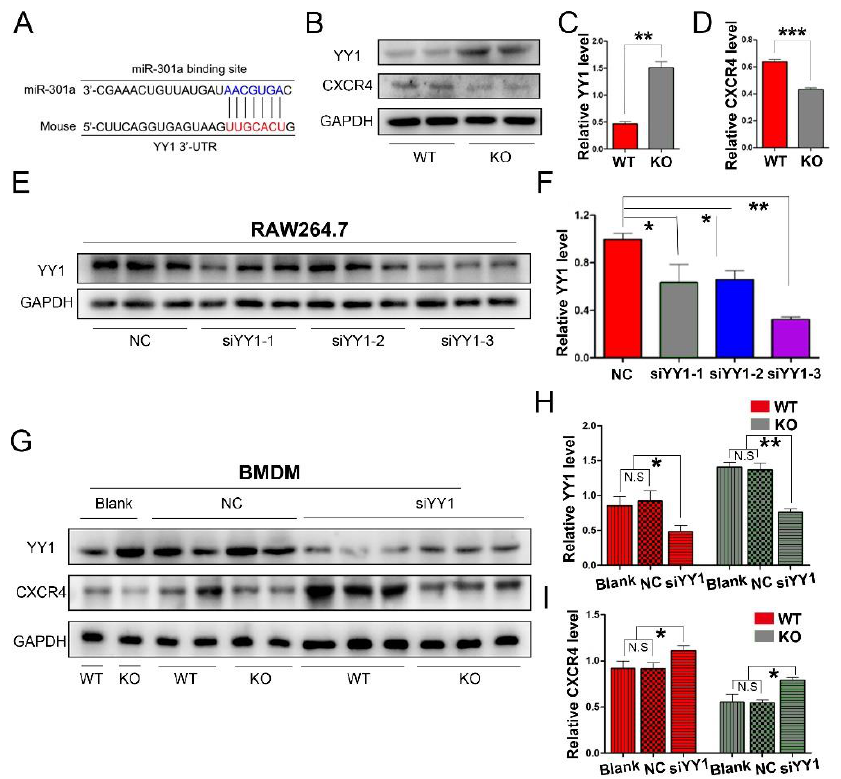
Figure 3. miR-301a KO in macrophages enhances the expression of YY1 and inhibits the expression of CXCR4. ( A ) The Targetscan database analysis suggested that miR-301a directly targets YY1. ( B ) Western blots and ( C , D ) statistical analysis illustrate that miR-301a knockout in macrophages up-regulates the protein level of YY1 and reduces the protein level of CXCR4 compared to WT group. ( E ) Western blots and ( F ) quantification analysis of YY1 expression inhibition by using YY1 siRNAs in RAW264.7 cells. ( G ) Western blots and ( H , I ) quantification of YY1 and CXCR4 expression in siYY1-3-transfected BMDM illustrate that the up-regulation of YY1 and the down-regulation of CXCR4 by miR-301a knockout are reversed by down-regulation of YY1. Data are expressed as the mean ± SEM ( n = 3 for each group, N.S: p ≥ 0.05, * p < 0.05, ** p < 0.01, *** p < 0.001).